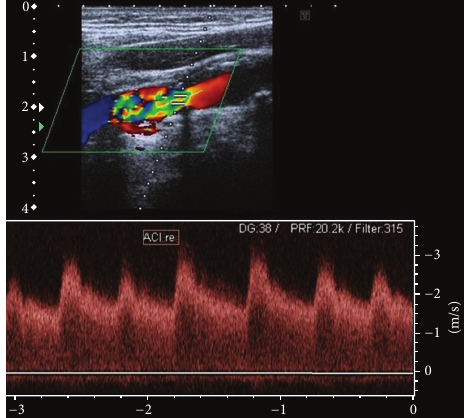
Figure 2: Doppler ultrasound assessment of the right internal cerebral artery showing a critical stenosis with a systolic maximal flow velocity of > 3